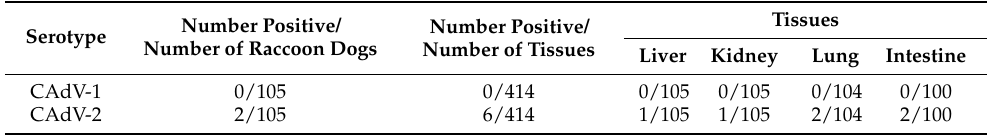
Table 2. The number of positive results for presence of CAdV-1 and 2 in the total number of raccoon dogs and tissue samples